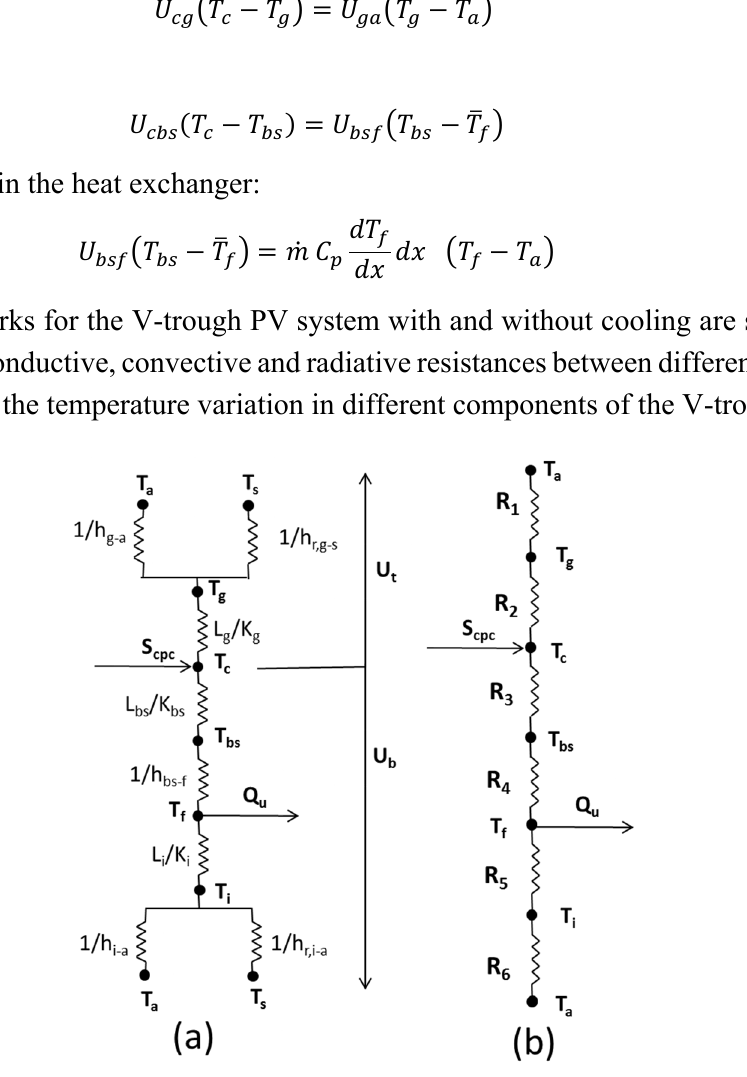
Figure 2. Thermal network for V-trough PV system with cooling ( a ) in terms of conduction, convection and radiation resistances; ( b ) in terms of resistances between